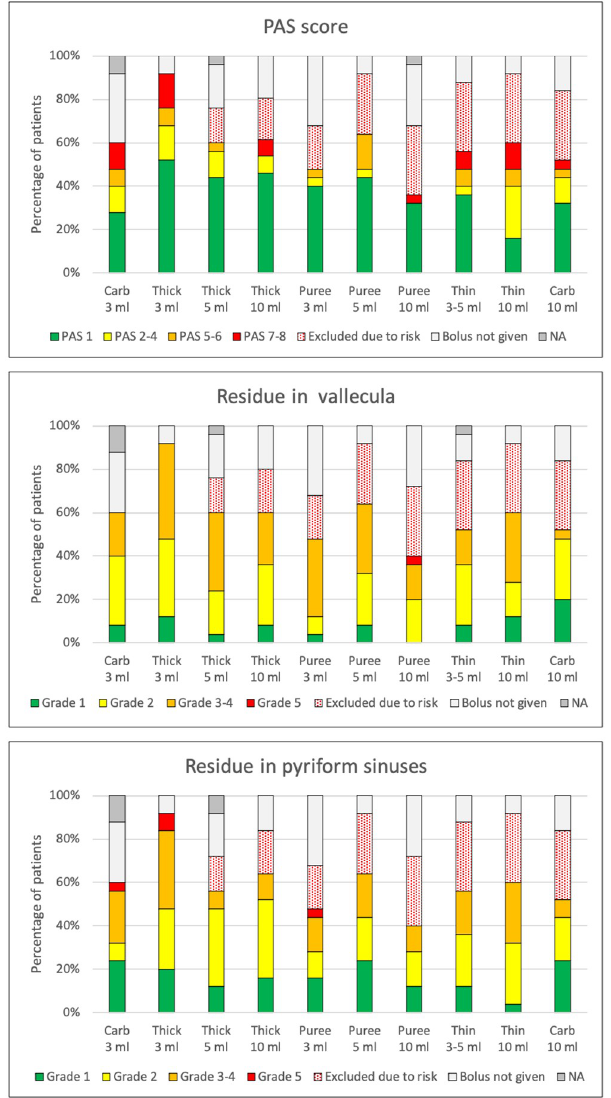
Fig 1. Penetration, aspiration, and residue during swallowing in COVID-19 patients treated in the ICU at the time of the first FEES examination. Proportions of different degrees of impairment for boluses of different consistencies (carb = carbonated water, thick = mildly thick liquid, and thin = thin liquid). PAS denotes Penetration- Aspiration Scale (1 = no penetration or aspiration, 7–8 = aspiration to trachea; see Table 1). Residue after swallow is evaluated with the Yale Pharyngeal Residue Severity Scale (grade 1 = no residue, grade 5 = filled to the epiglottic rim or to the aryepiglottic folds, respectively; see Table 1). Dotted red filling represents patients in whom the boluses were considered unsafe and not given due to high risk for aspiration. Grey filling indicates the proportion of patients who did not receive the particular bolus for other reasons. NA denotes that the rating was not possible to perform due to insufficient visibility on the